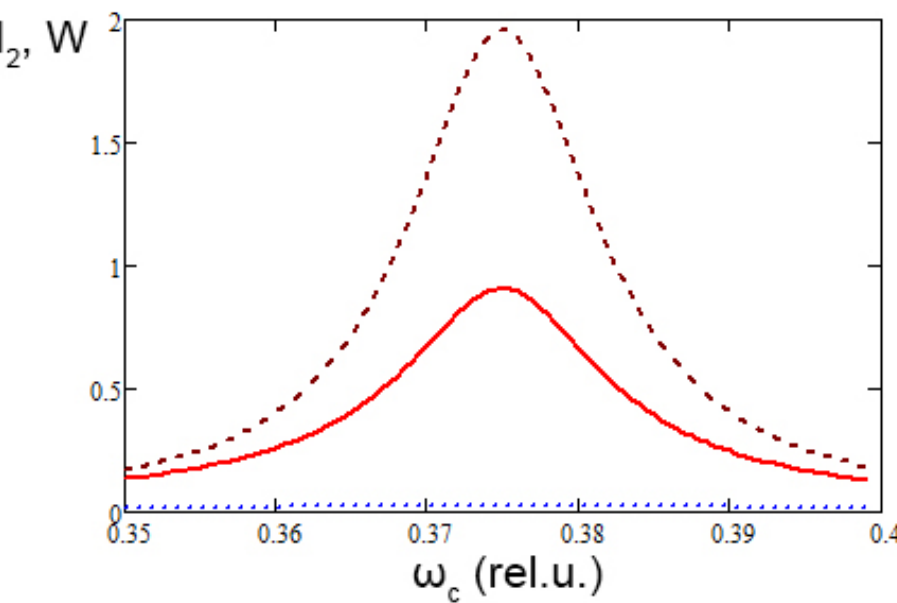
Figure 4. Short pulses τ < T 2 , moderate saturation s = 9 ( τ = 150, T 2 = 10 3 , Ω 0 = 0.02): solid line—Bloch equation solution, dotted line—generalized Karplus–Schwinger approach, dashed line—Lorentz profile neglecting saturation